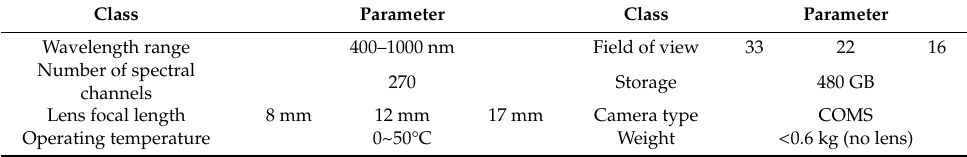
Table 1. Nano-Hyperspec hyperspectral imaging sensor parameter